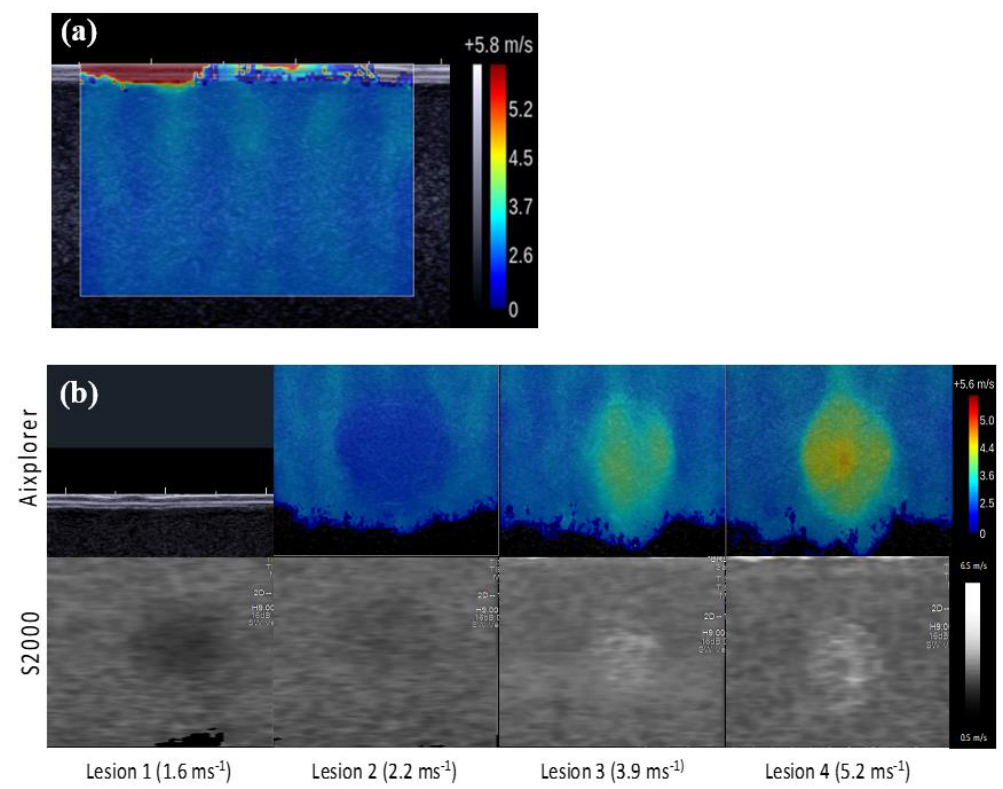
Figure 3. Showing: ( a ) Aixplorer image of a homogenous region of the phantom to illustrate the bands of greater shear wave speed (artefacts) observed. ( b ) Example elastograms of the lesions contained within the CIRS 049 phantom using the Aixplorer and the S2000. Nominal shear-wave speeds are given below the images.